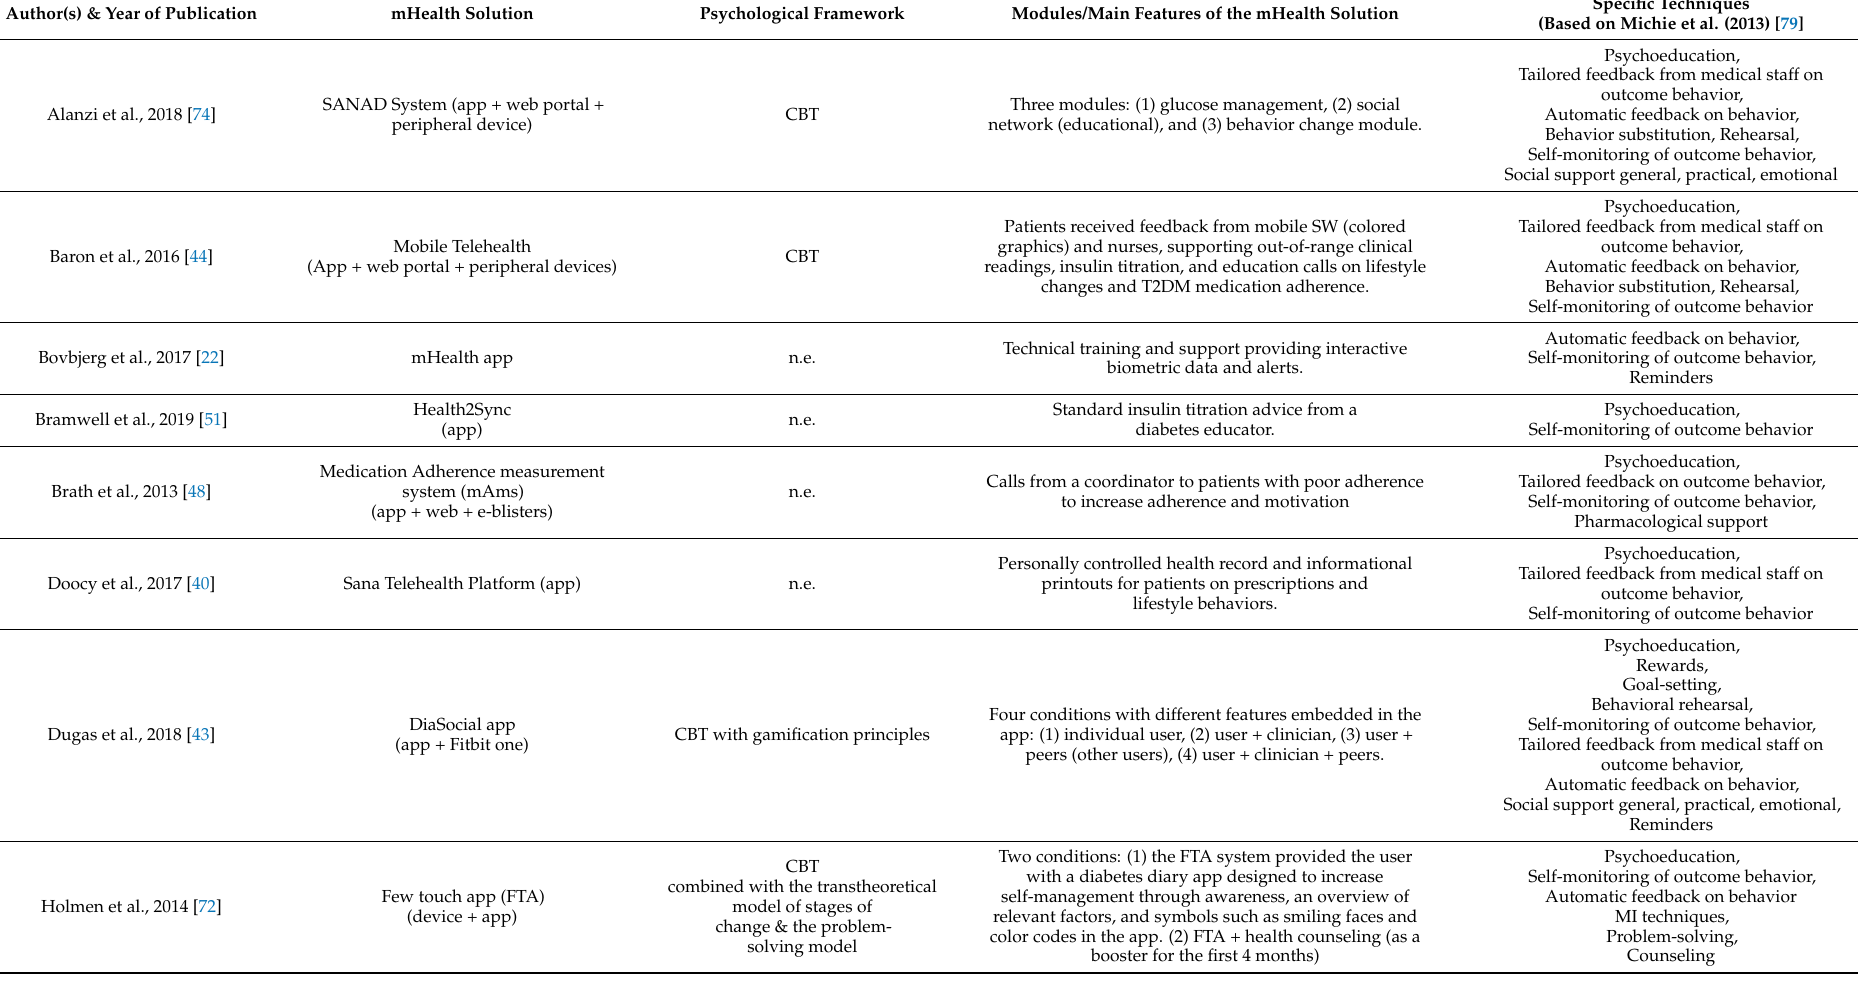
Table 2. Psychological framework and specific techniques implemented in mHealth